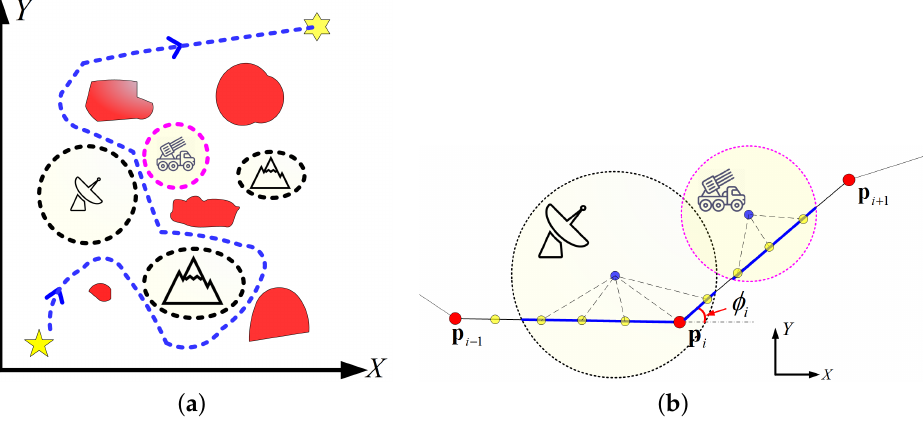
Figure 4. Illustration of the path planing in a 2D C-space. ( a ) the 2D C-space; ( b ) UAV path formed by connecting the